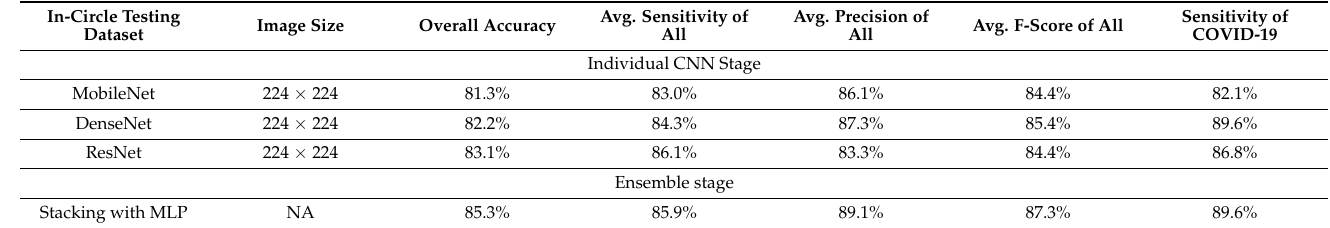
Table 1. Performance comparison of individual CNN to the ensemble.